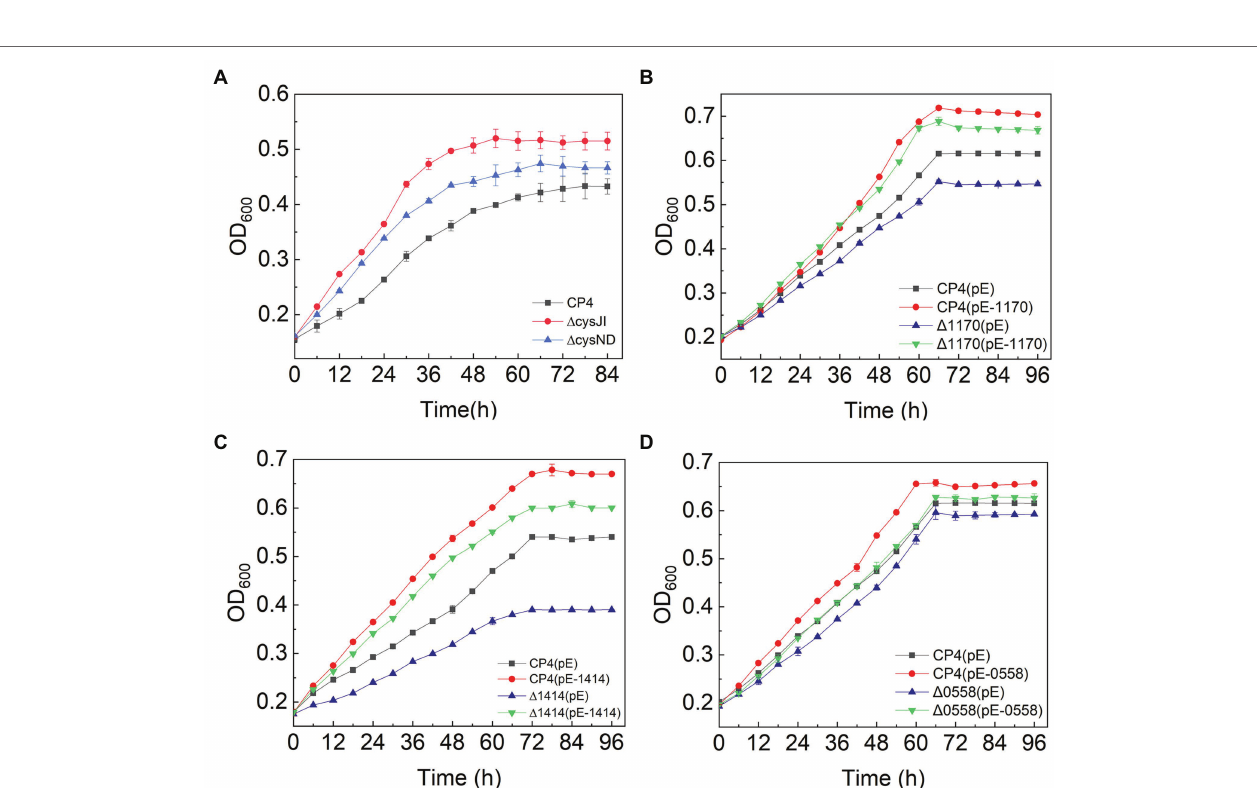
FIGURE 5 | Growth curves of engineered strains of CysJI , CysND , ZCP4_1,170, ZCP4_1,414, and ZCP4_0558 genes.